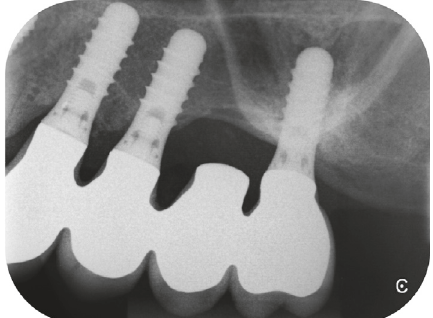
Figure 7: Two years after the closure of OAF; the radiographic control showed a stable crestal bone